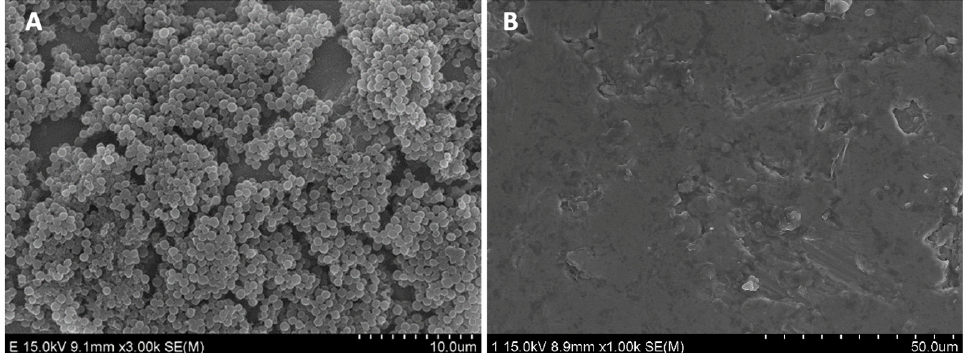
Figure 6. FE-SEM images of ( A ) biofilm on bare Ti implant and ( B ) LVF treated surface on 4-MLTRPB Ti implants after S. aureus (10 7 CFU mL − 1 ) incubation for 12 h at 37 ◦ C.